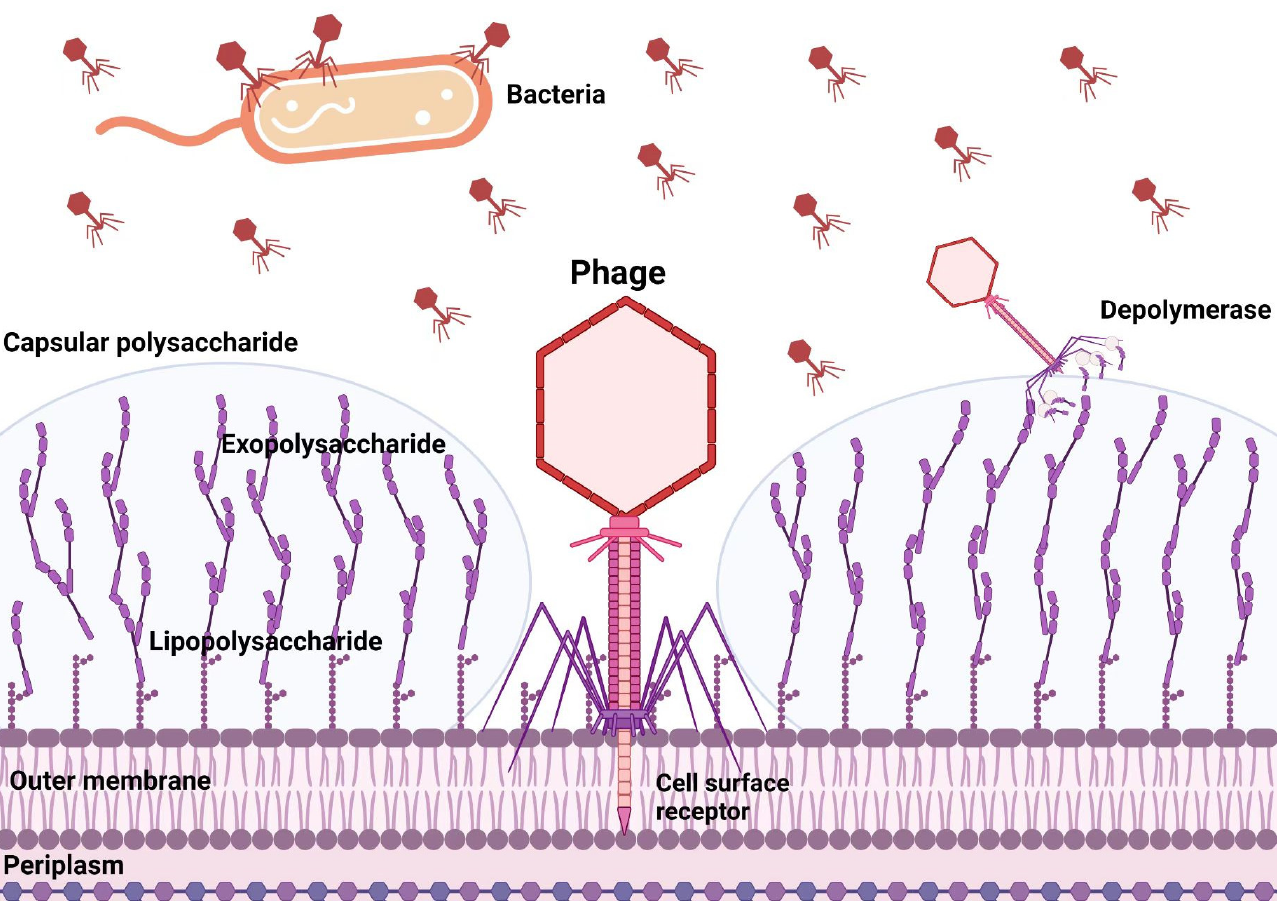
Figure 2. Polysaccharide depolymerase of bacteriophages attacks on different targets.